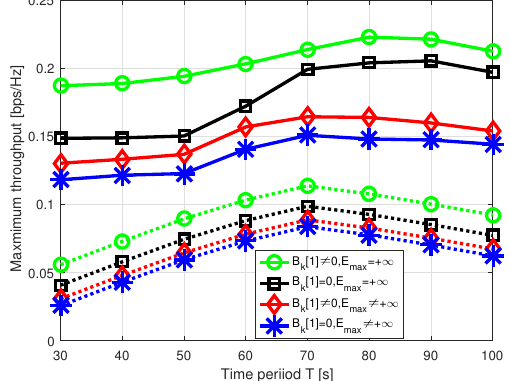
Figure 9. Minimum throughput versus time period T .